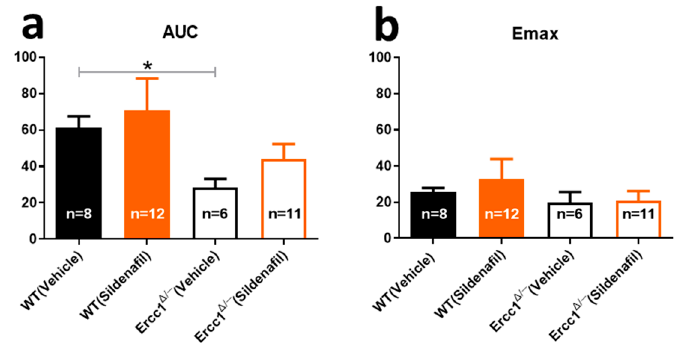
Figure 2. Cutaneous reactive hyperemia in Ercc1 Δ / − mice versus their WT littermates measured with laser Doppler, expressed as: ( a ) AUC and ( b ) maximum response (Emax). The number of mice per group is shown in the bar. Statistical differences were analyzed by one-way ANOVA corrected for multiple testing (*, p < 0.05).